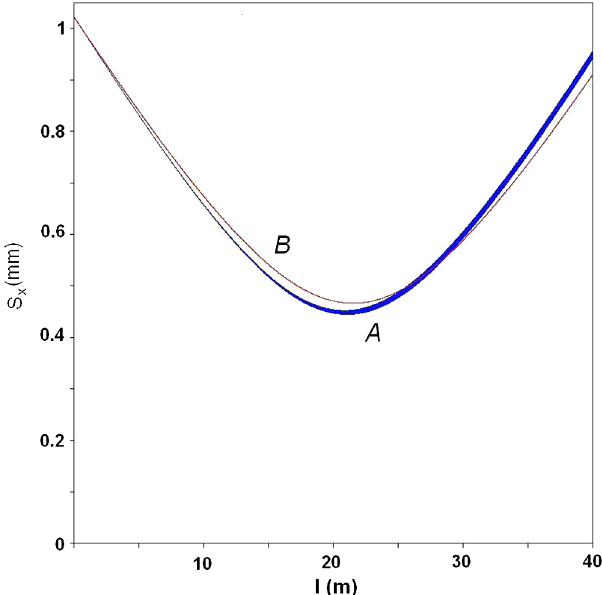
FIG. 11. Reconstructed beam envelope for the focusing Crystal 4. The width of the line A corresponds to the measure- ment uncertainties [20] Lines A and B were calculated using Eqs. (1) and (8),